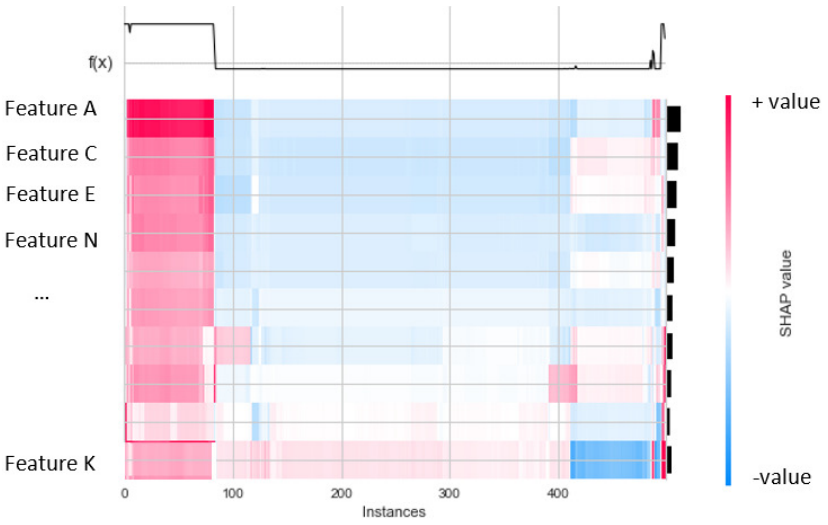
Figure 1. Example of heatmap